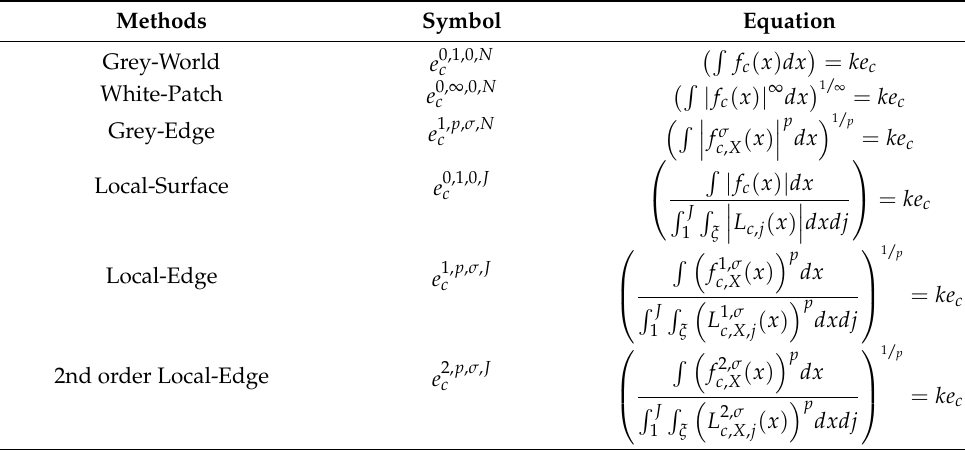
Table 1. A summary of the different illuminant estimations